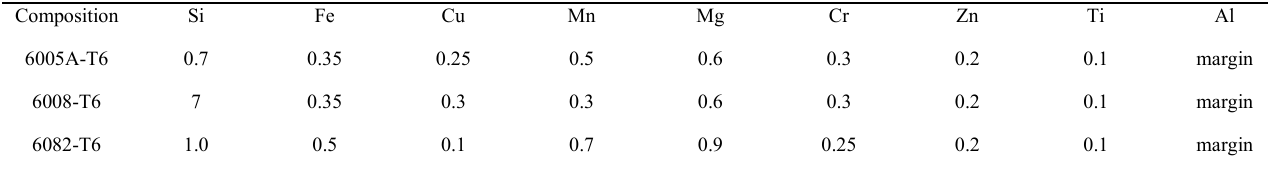
Table 1. Three material